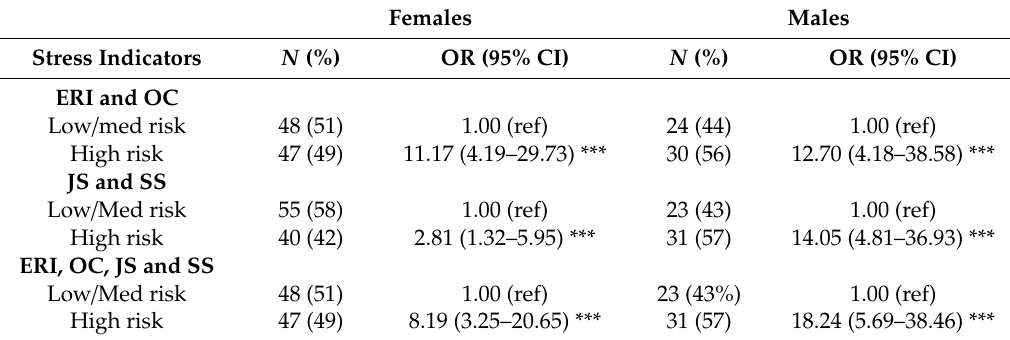
Table 3. Odds ratios for psychological distress by combined stress